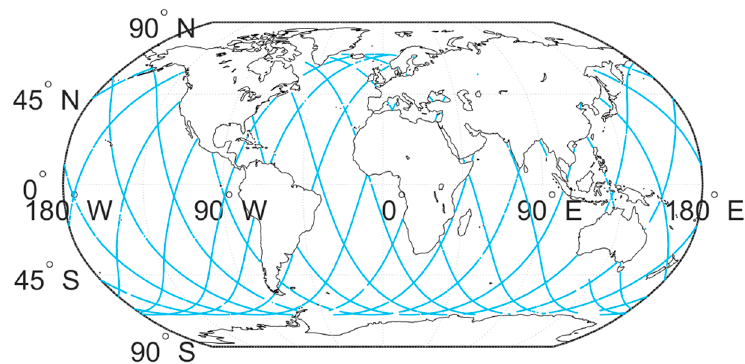
Figure 3. Daily ground track of Jason-2 on 8 March 2014.